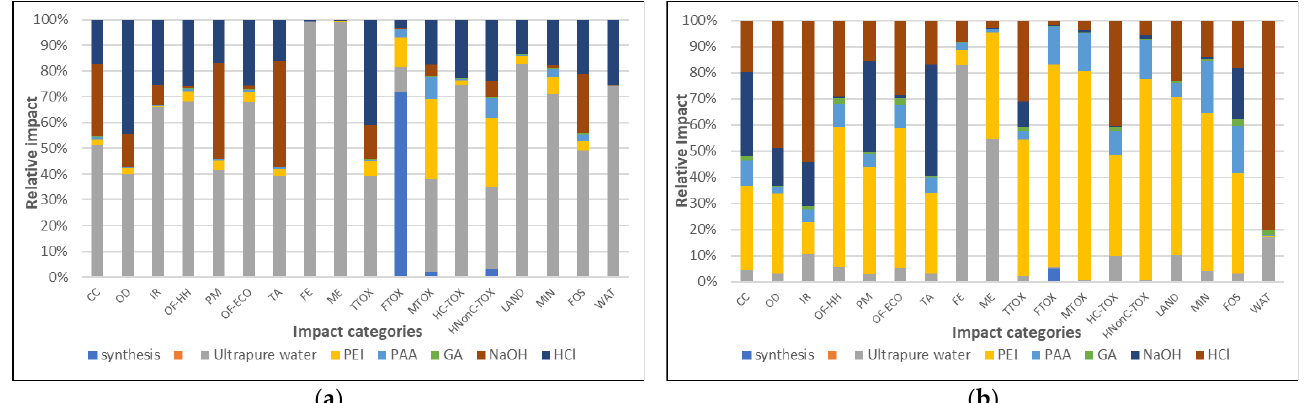
Figure 3. Environmental profile structures of the polymeric particle coating materials ( a ). LbL- IS/(PEI/PAA) 4.5 (r = 0.1); ( b ) One-pot IS/(PEI/PAA) c (r = 0.1).